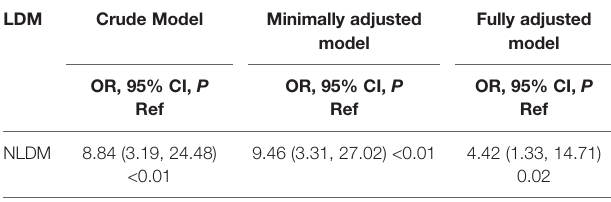
Crude Model adjusted for: None. Minimally adjusted model adjusted for: BMI. Fully adjusted model adjusted for: BMI, abdominal pain, vaginal pH, menstrual cycle, gravidity, previous spontaneous abortion, previous infertility, and previous uterine cavity